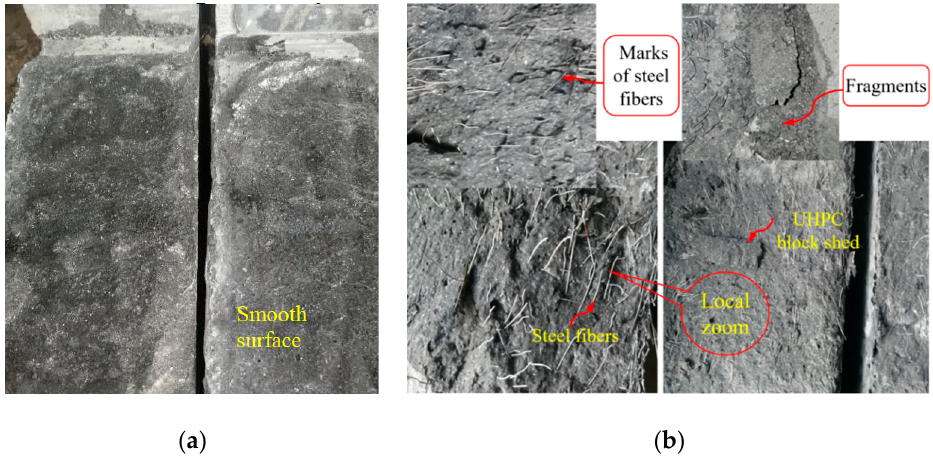
Figure 13. Direct shear failure of cast-in-place specimens: ( a ) without steel fibers and ( b ) doped with steel fibers.